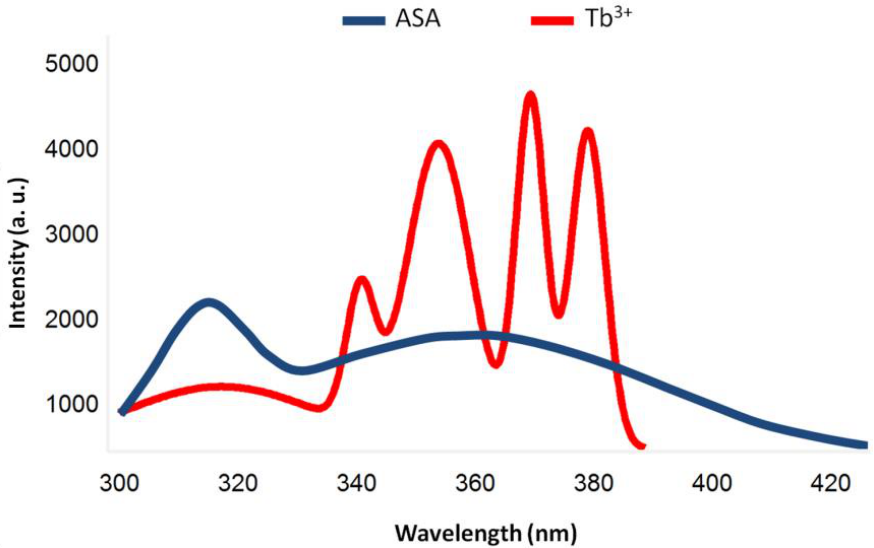
Figure 4. Excitation spectra for Tb 3+ and ASA measuring the 540 nm peak.